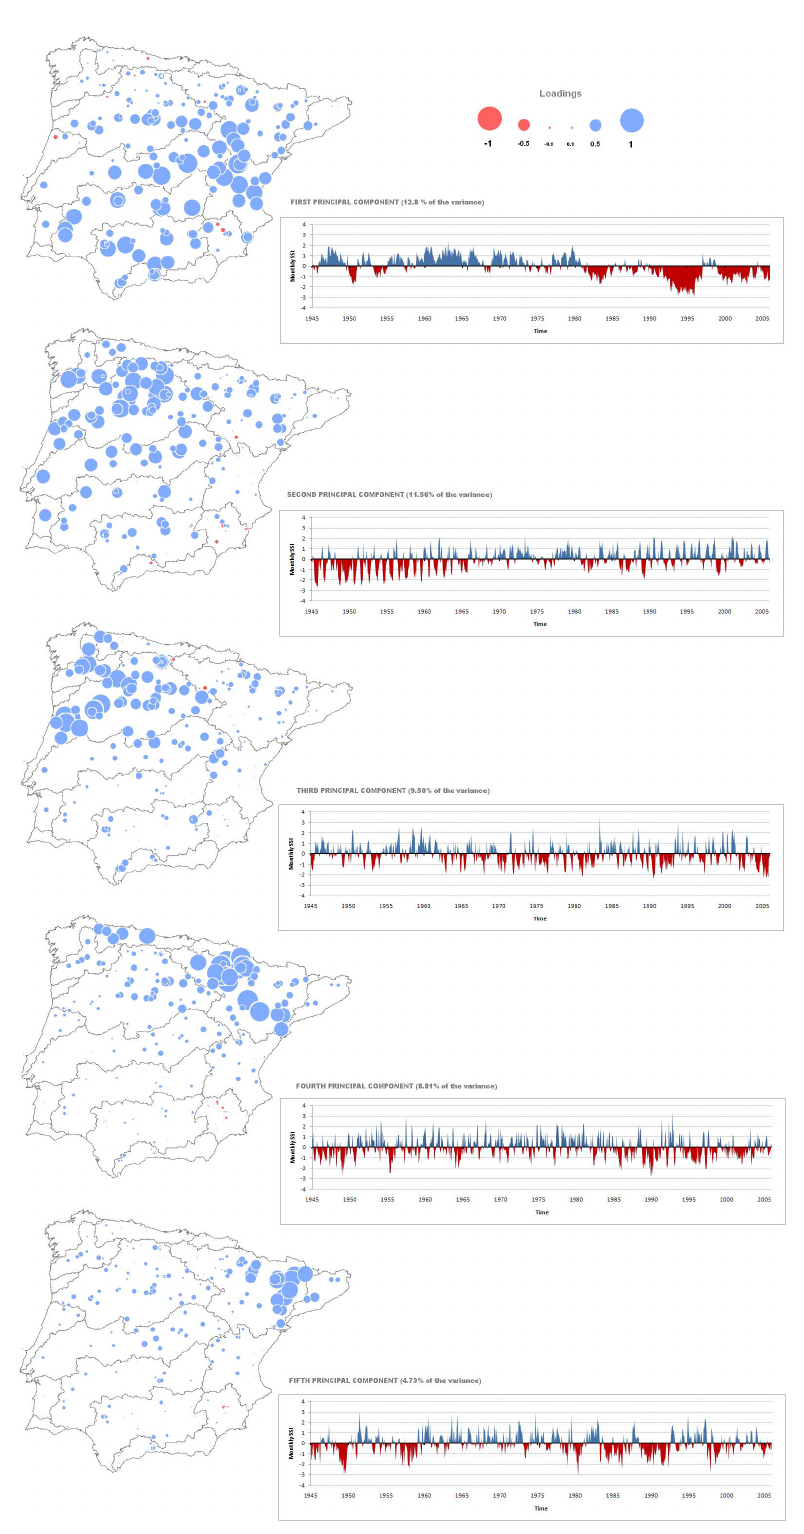
Fig. 4. Spatial distribution of the PCA loadings for the first principal components (1st to 5th), and temporal evolution of the principal components (1st to